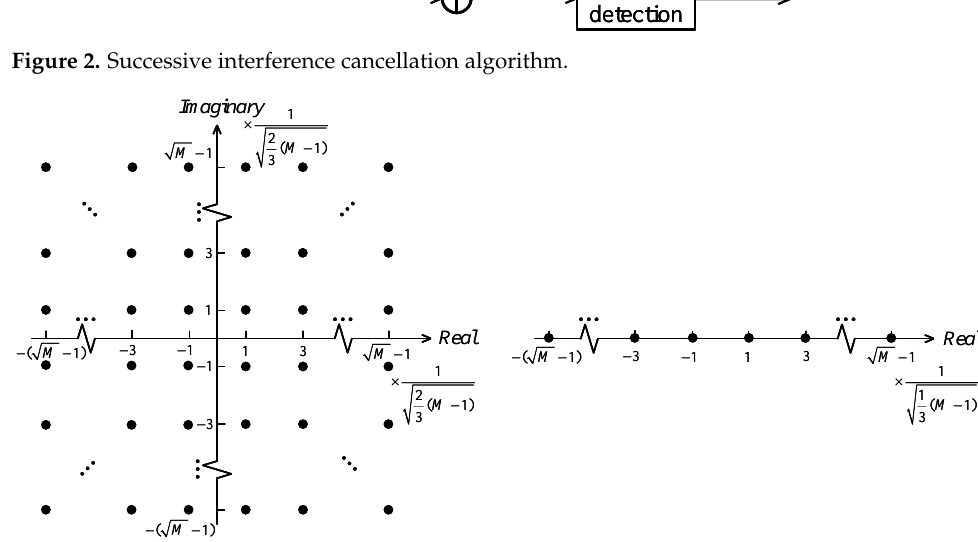
Figure 3. Constellation diagrams of M-order QAM in OFDM ( left ) and FBMC ( right